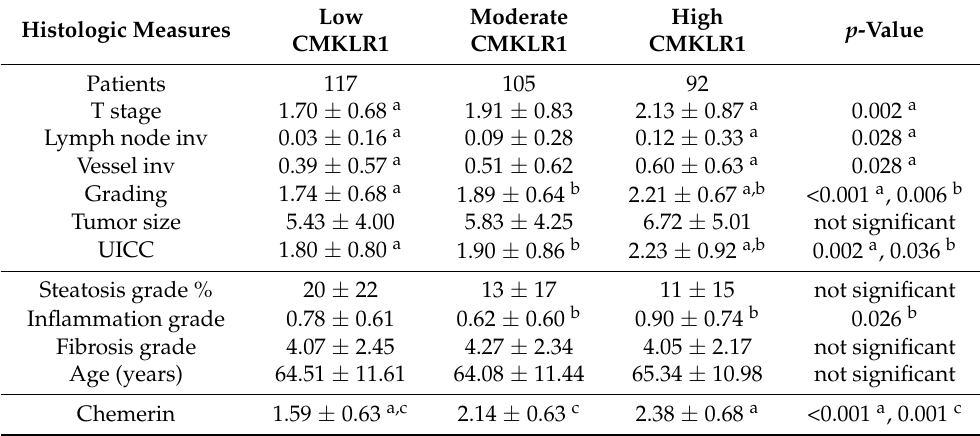
Table 6. T stage, lymph node invasion, vessel invasion, grading, tumor size, UICC stage, steatosis, inflammation, fibrosis stages, age, and chemerin scores of male patients stratified with low, moderate, and high CMKLR1 protein in the tumors. a: comparison of tumors with low and high CMKLR1, b: comparison of tumors with moderate and high CMKLR1, and c: comparison of tumors with low and moderate CMKLR1 (inv, invasion).